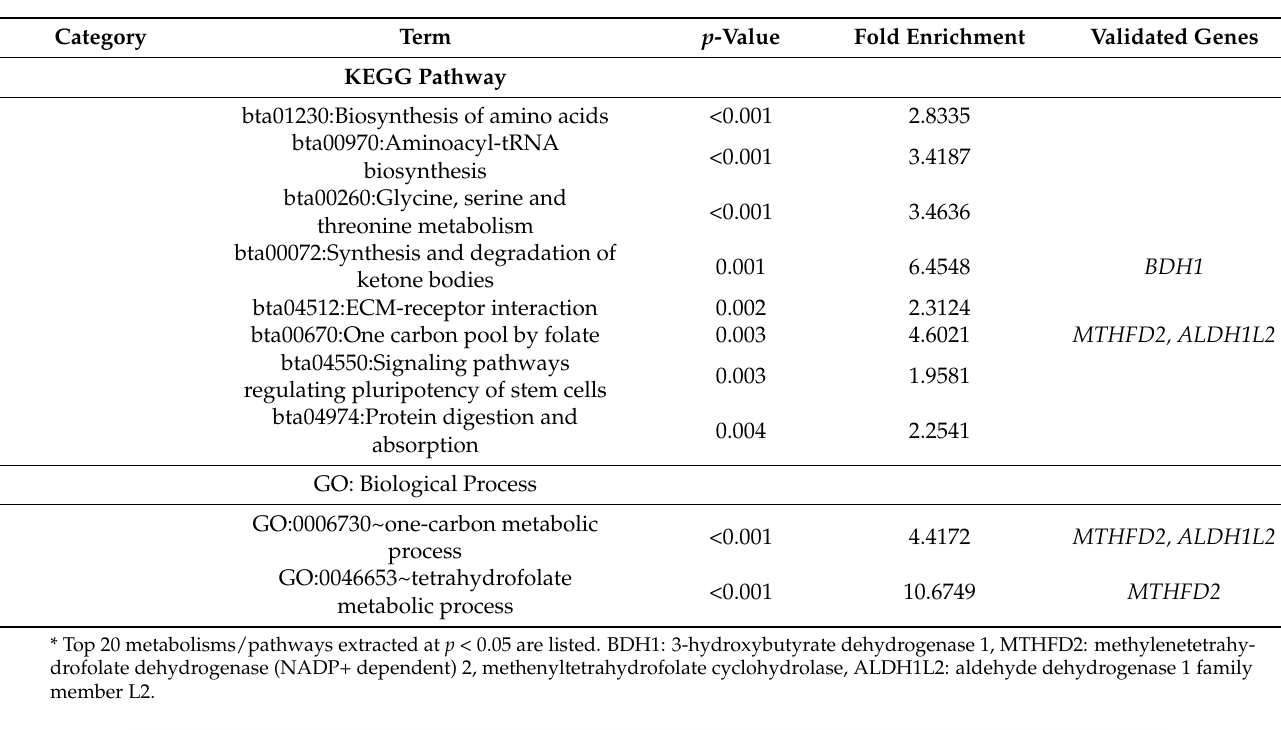
Table 5. Fetal growth and energy associated metabolisms and pathways extracted from upregulated genes *. Category